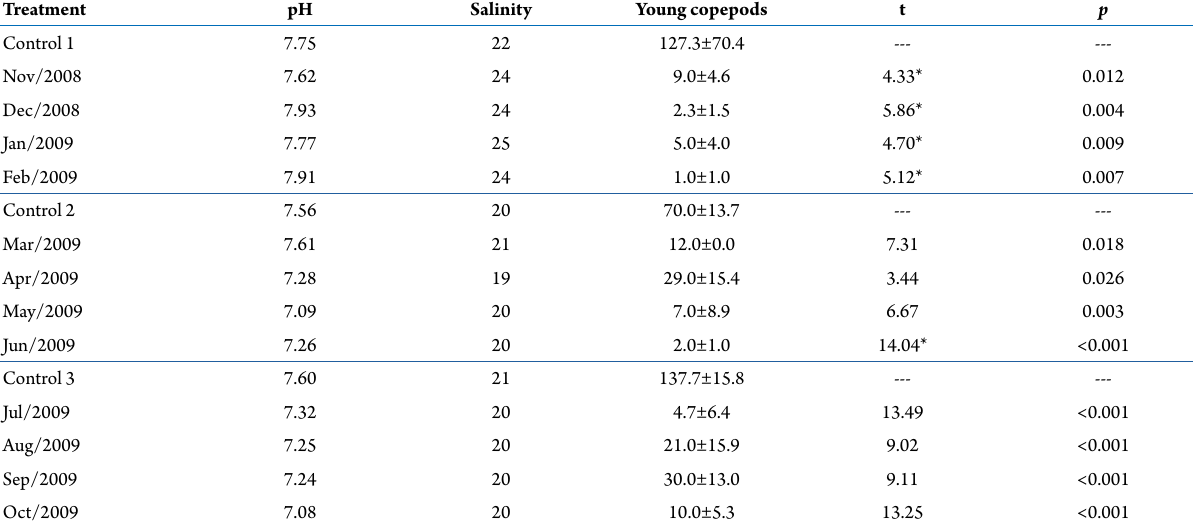
Table 1. Abiotic variables (pH and salinity) and number (mean ± standard deviation) of young copepods of Nitocra sp. by treatment. Each control represents the sediment reference tested with a set of sediment samples collected monthly in the study area. For the comparison of young copepods between each month and its respective control, t-value and respective p -value are presented. * indicates when the fourth root transformation was necessary to meet the assumptions of the analysis. For all months, t-tests were made assuming equal variances between groups, except for ‘March 2009’, in which a t-test was made assuming unequal variances. Treatment pH